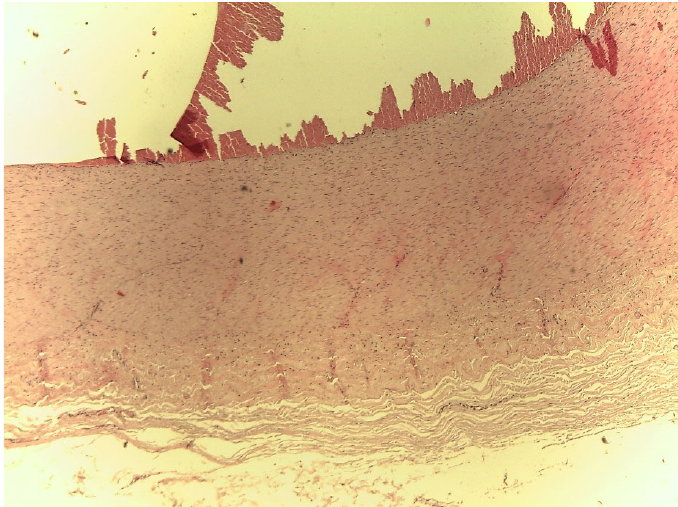
Figure 2. Bovine carotid artery with false aneurysm. Haematoxylin–Eosin (H.E.) (20×).